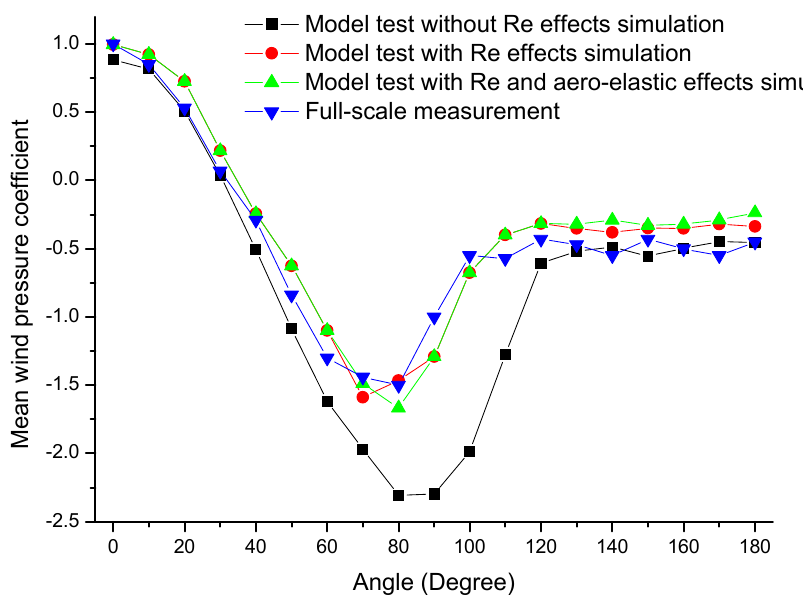
Figure 11. Mean wind pressure distributions from full-scale measurement and model tests. Using the data presented in Figures 11 and 12, the three adverse effects of the tradi- tional ABL wind tunnel pressure measurement technique are respectively calculated